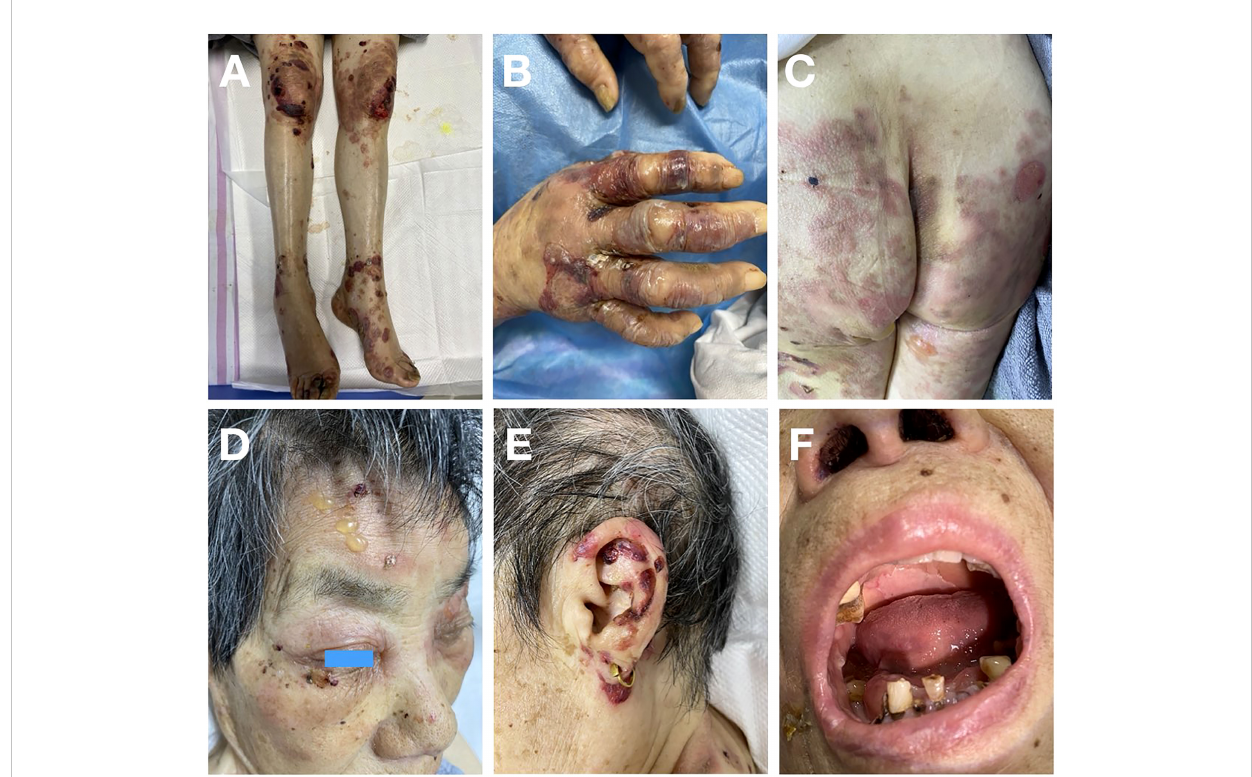
FIGURE 1 Clinical features of this patient. (A, B) Erythema, blisters and bloody crusts on the knees and lower limbs (A) and on the hands (B) . (C) Erythema and blisters on the buttocks and thighs. (D) Blisters on the face and bloody crusts around the eye. (E) Bloody crusts around the ear. (F) Sever mucosal lesions on the lips and in the oral